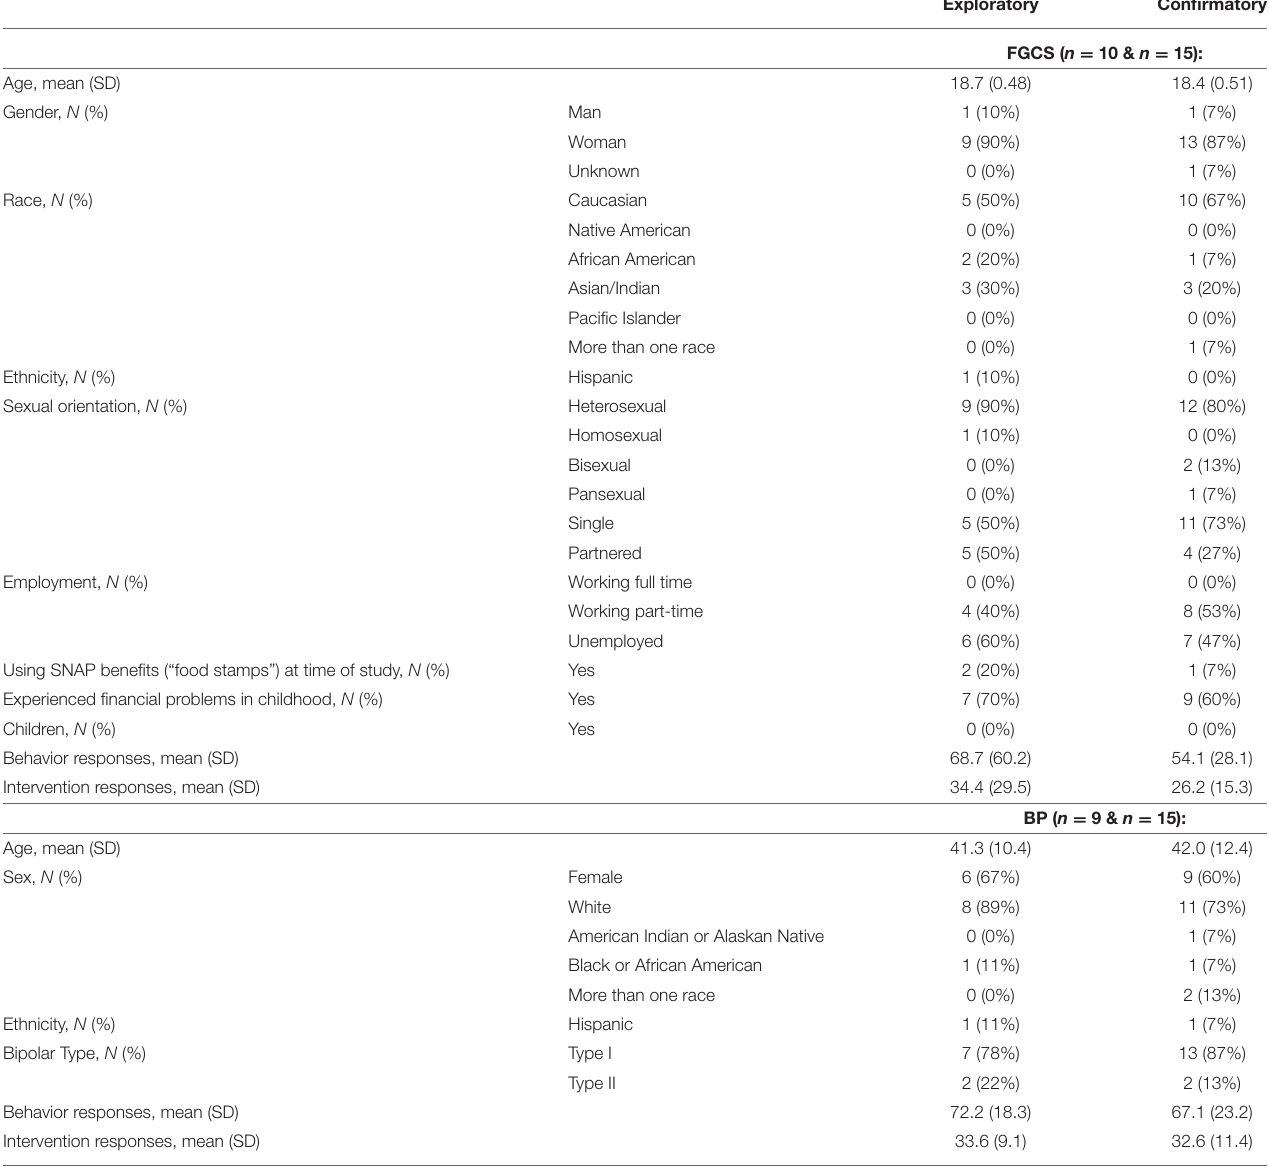
TABLE 1 | Sample characteristics by cohort.